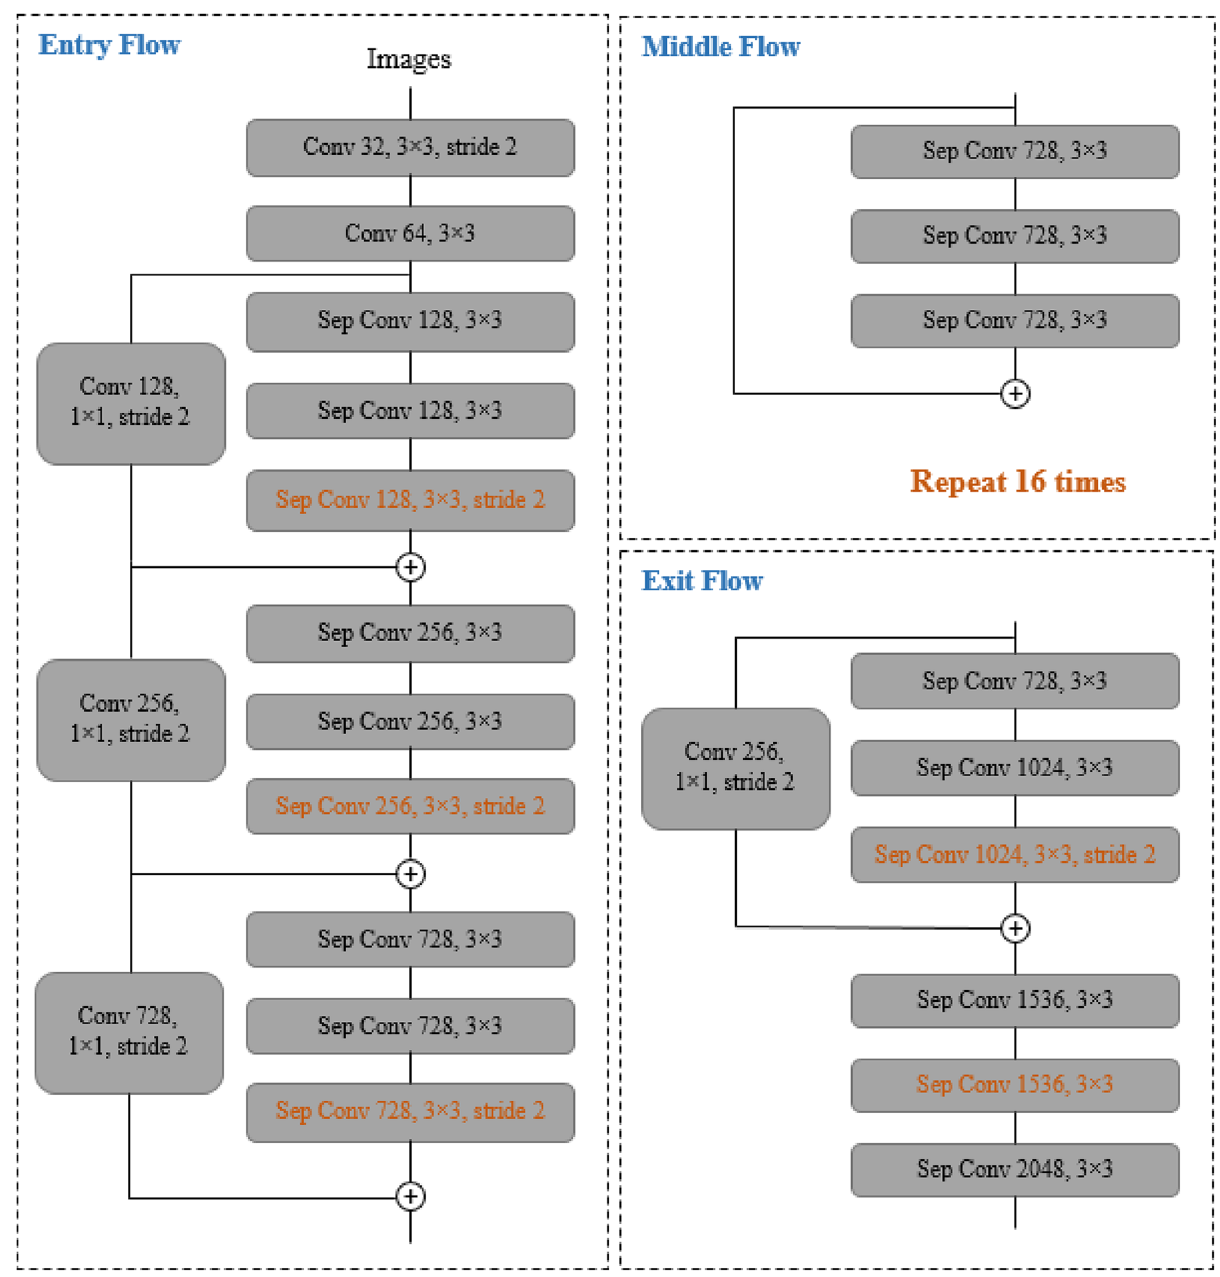
Figure 8. The modified Xception architecture used in DeepLabv3+: (1) has higher number of layers, (2) all max pooling layers are replaced by depthwise seperable convolutions with striding and (3) extra batch normalization and ReLU are added after each 3 × 3 depthwise convolution 42